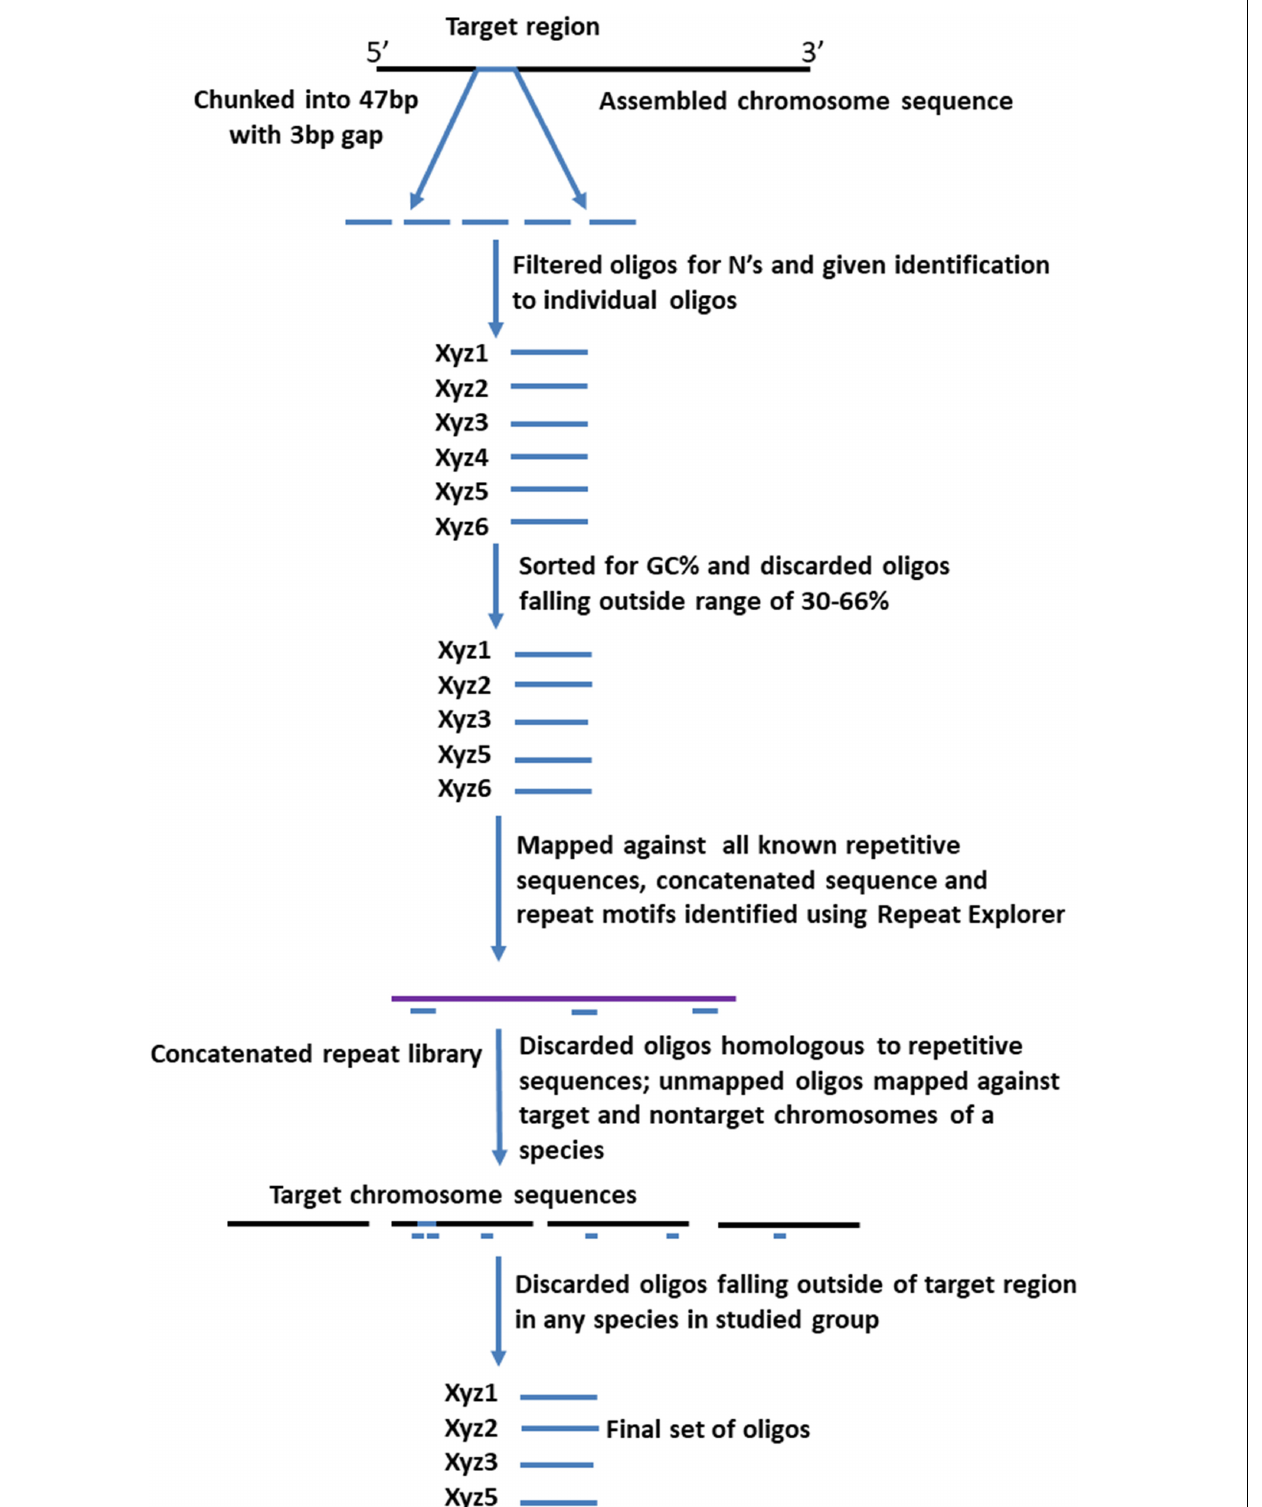
Frontiers in Plant Science |